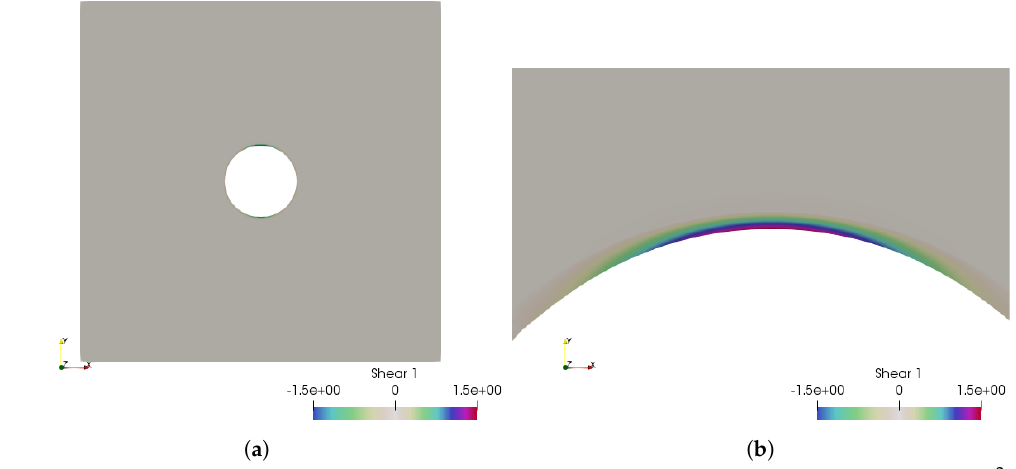
Figure 12. Case 1: the fluid shear stress representation, which is between − 1.5 and 1.5 dyn/cm 2 , for h 2 -refinement. ( a ) The fluid shear stress overview; ( b ) zoom over the higher shear stress